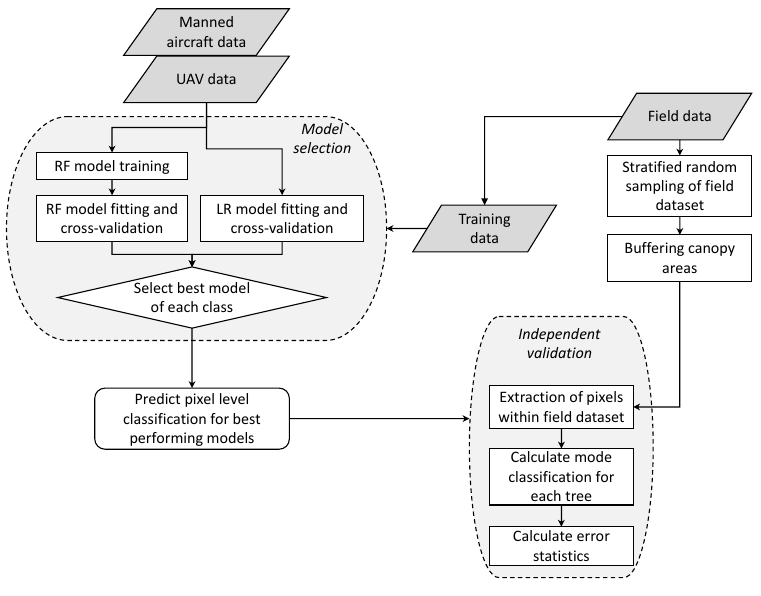
Figure 1. A schematic overview of the methodology used in this